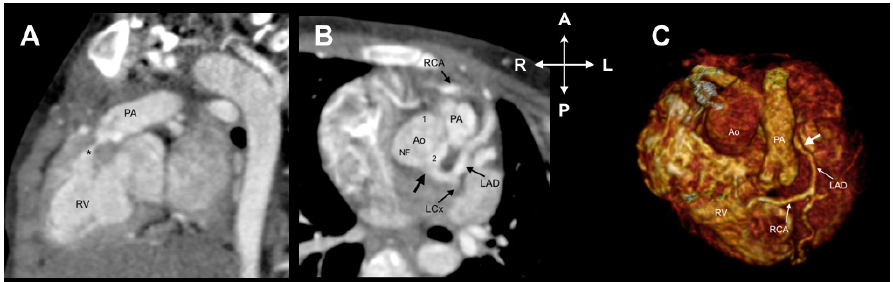
Figure 4. Case 9. A 4-year-old child with tetralogy of Fallot. ( A ) Oblique image showing infundibu- lar pulmonary stenosis (*). ( B ) Axial image reveals coronary origins clockwise rotated along with the aortic root. According to the Leiden Convention, it is 2RLCx and by Lipton classification, it is LIIA. ( C ) A 3D volume-rendered image shows an anomalous origin of the RCA from the LAD. A: Anterior. Ao: Aorta. LAD: Left anterior descending coronary artery. L: Left. LCx: Left circumflex. P: Posterior. R: Right. RV: Right ventricle. NF: Non-facing sinus. PA: Pulmonary artery. RCA: Right coronary artery.